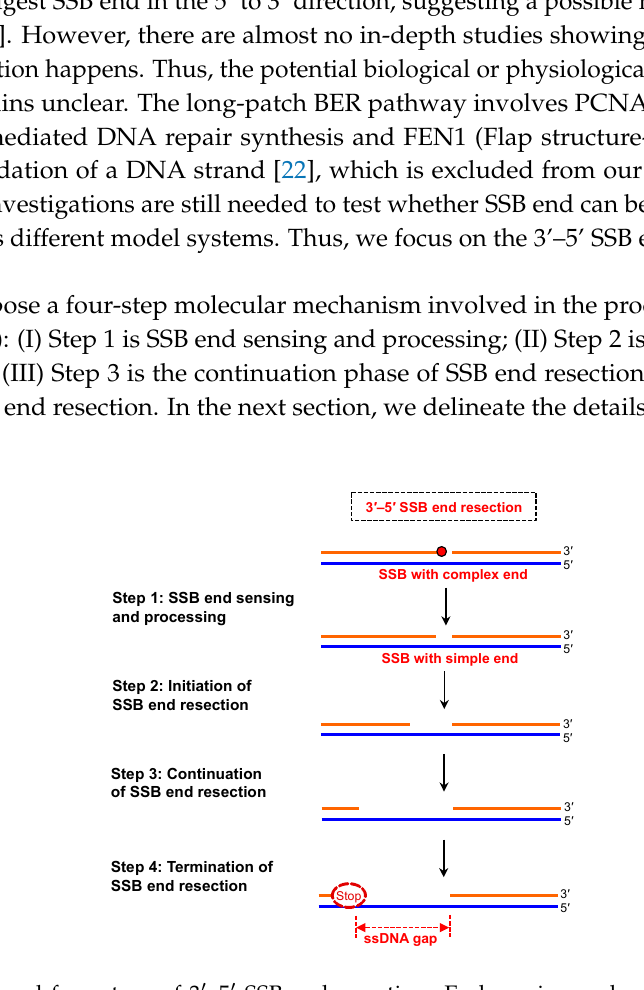
Figure 2. Proposed four steps of 3 ′ –5 ′ SSB end resection: End sensing and processing, initiation, continuation, and termination of SSB end resection.